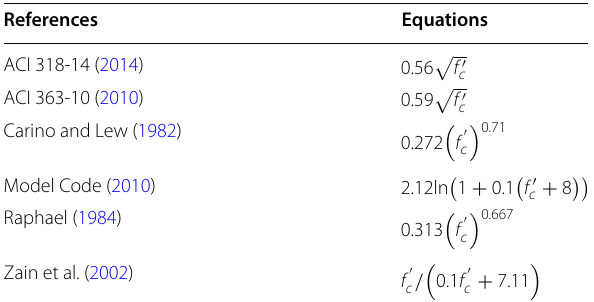
Table 9 Prediction equation of the splitting tensile strength.